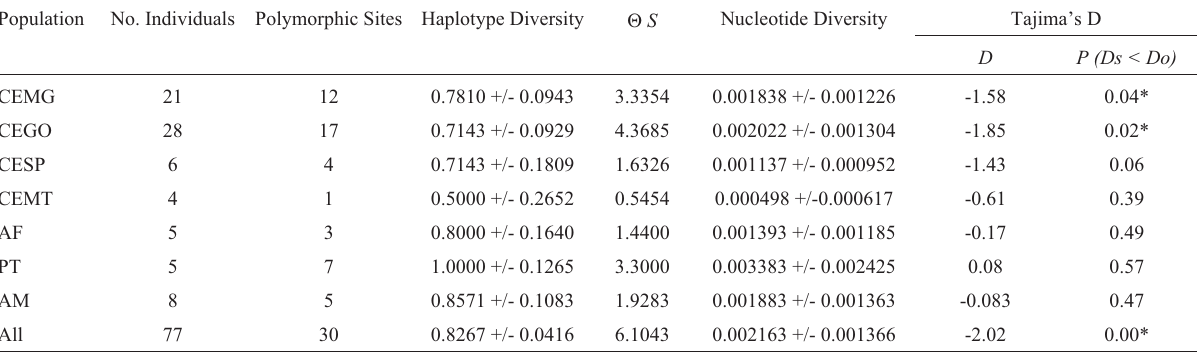
Table3 -Parametersofgeneticdiversityineachsampledpopulationof M.tridactyla ,andintheentiredataset.SignificantTajimasDvalues(p<0.05)are marked with an asterisk (*).